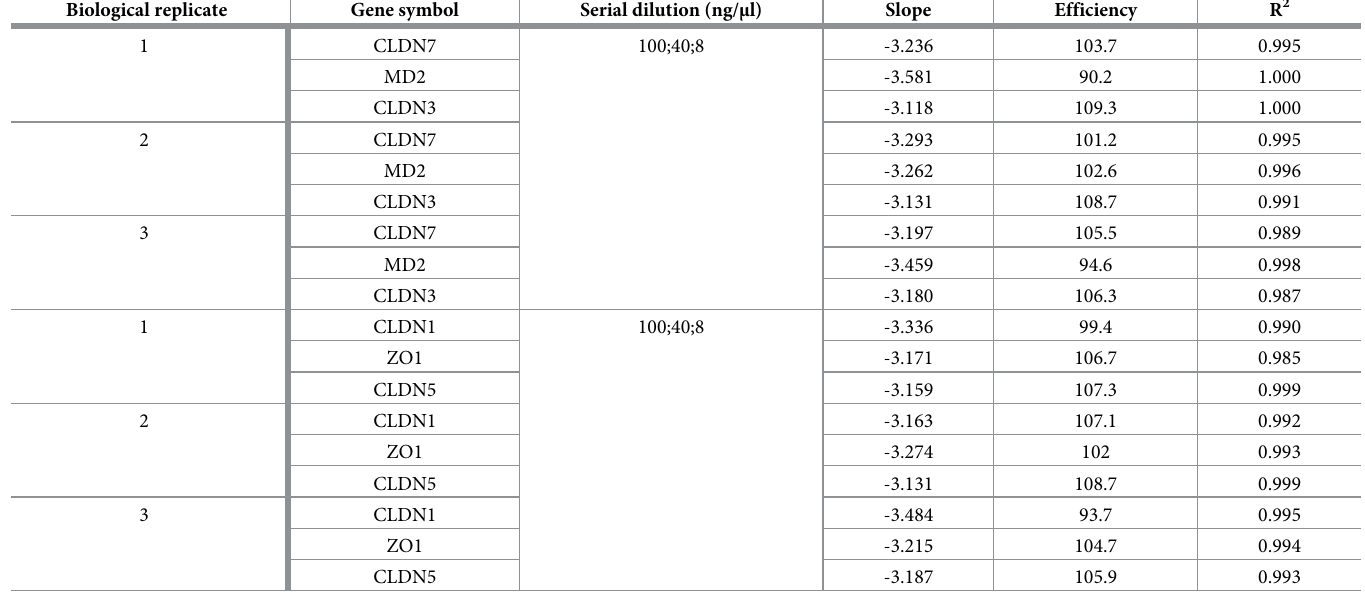
Table 4. Multiplex standardization for jejunum samples. Biological